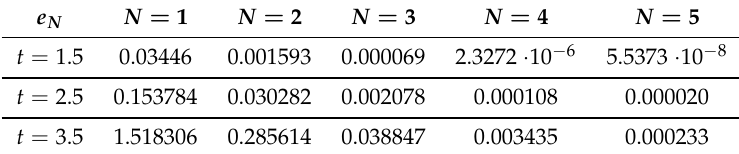
( x , t ) , of the truncated solution SP, X N ( t ) , to the random IVP (34) taking as Figure 7. Left : 1-PDF, f N 1 the order of truncation N ∈ { 1,2,3,4,5 } and the corresponding 1-PDF, f 1 ( x , t ) , of the exact solution ( x ,3.5 ) , with N = 5, is plotted together with SP at t = 3.5. Right : To facilitate the comparison, f N 1 f 1 ( x ,3.5 ) . Example 2. Table 3. Values of the error measure, e N , defined by (32) for different time instants, t ∈ { 1.5,2.5, 3.5 } , and orders of truncation to the approximate solution SP of (34), N ∈ { 1,2,3,4,5 } . Example